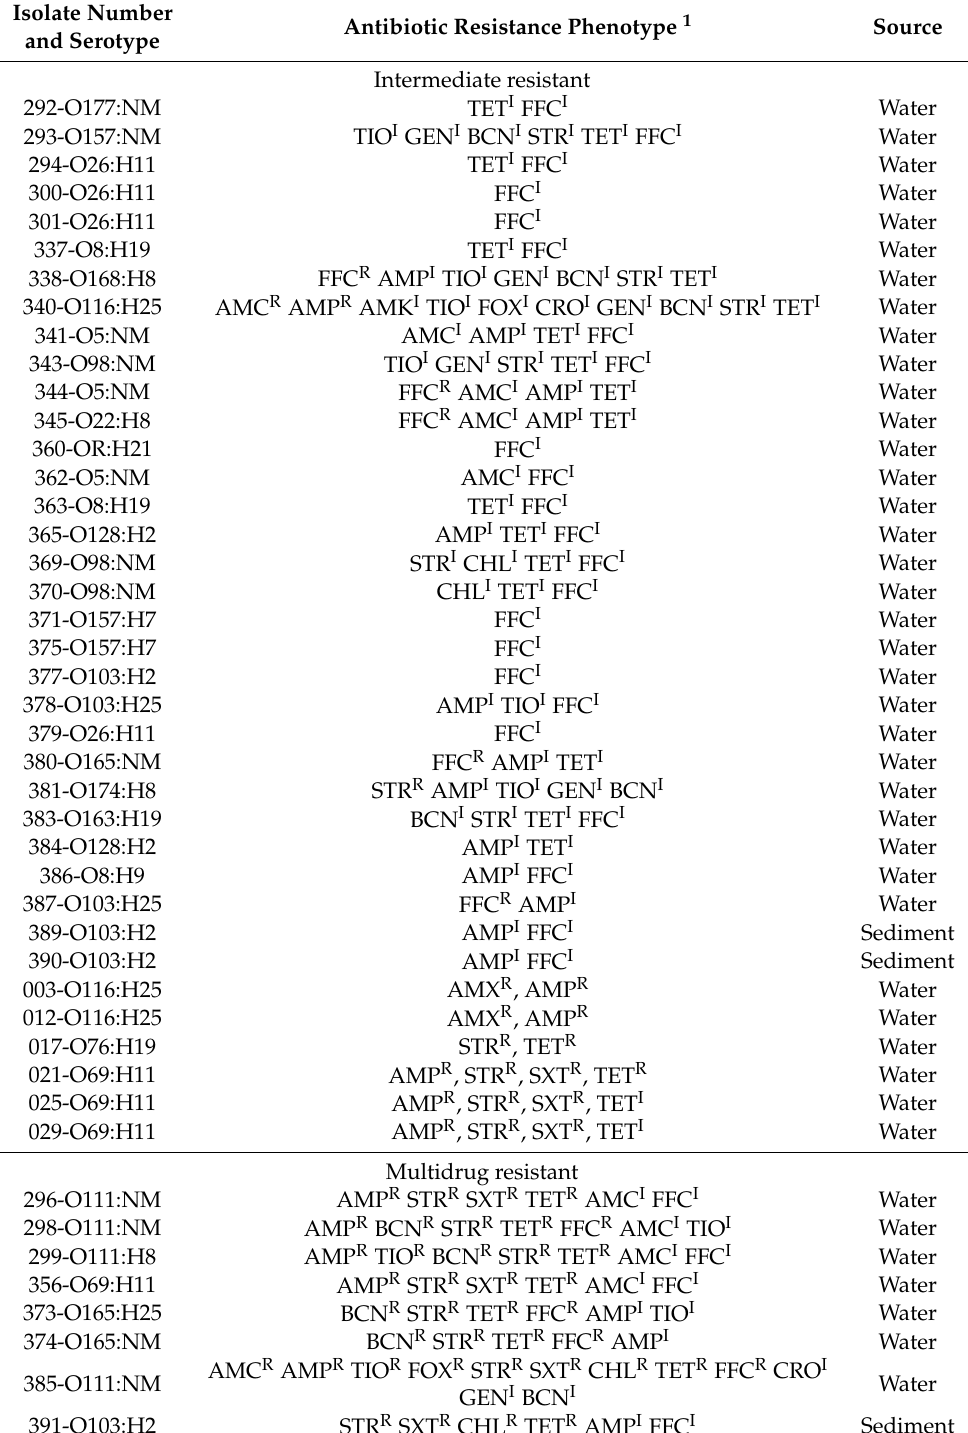
Table 1. Cont . Isolate Number and